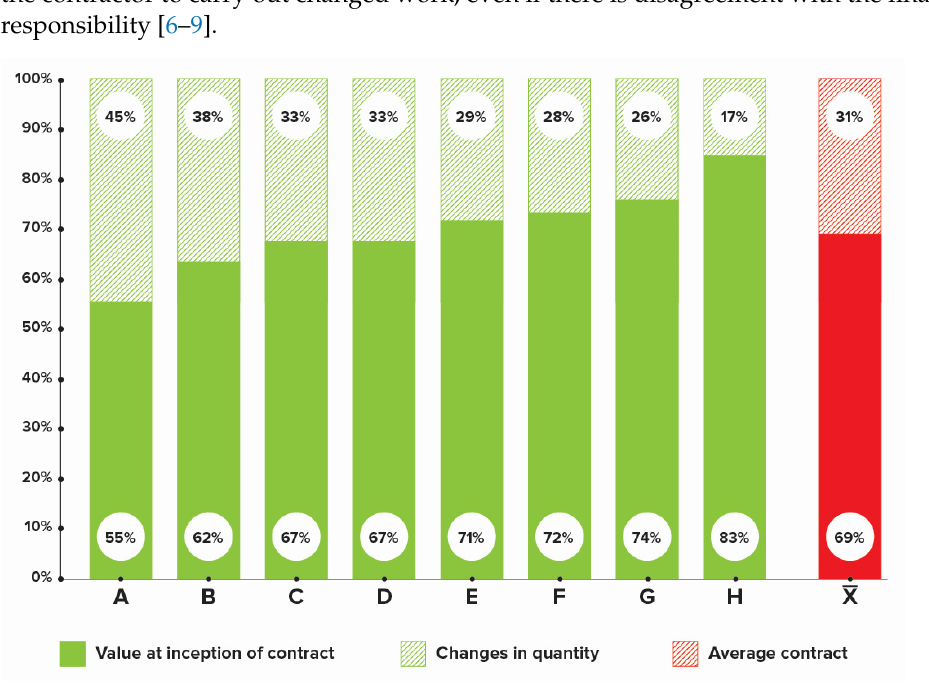
Figure 1. Percent of changes orders in eight Norwegian heavy construction projects [1].